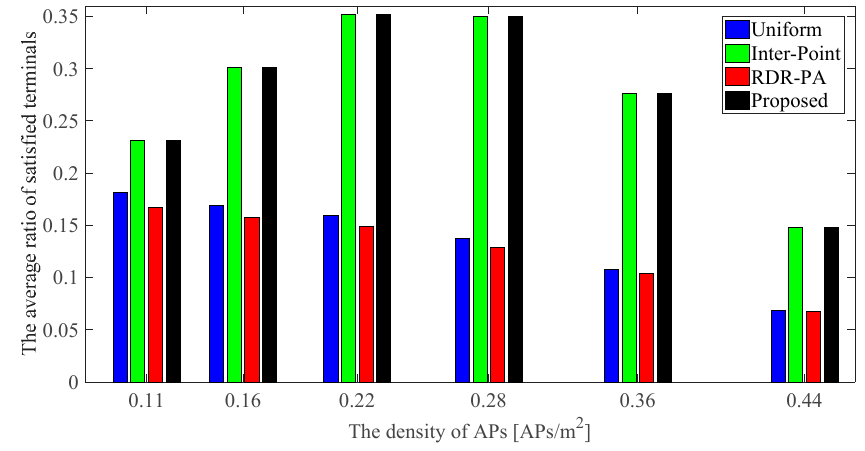
Figure 6. The average ratio of satisfied terminals versus the density of access points.